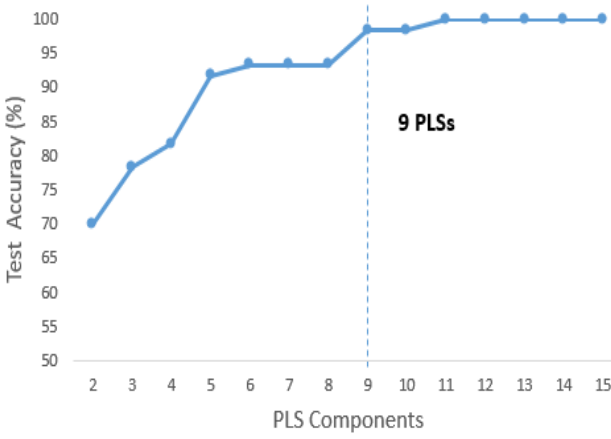
Figure 2. Accuracy rates vs. the number of PLS components in the urine sample dataset.